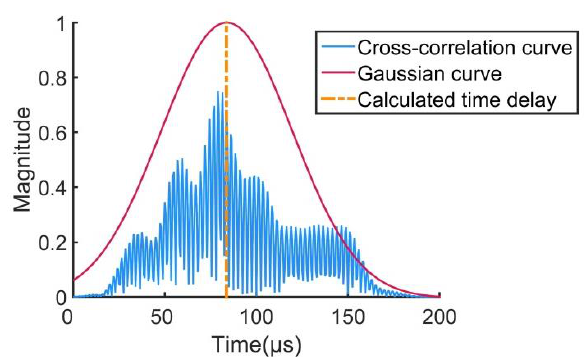
Figure 9. Cross-correlation curve calculated by sensor 1 and sensor 5 .